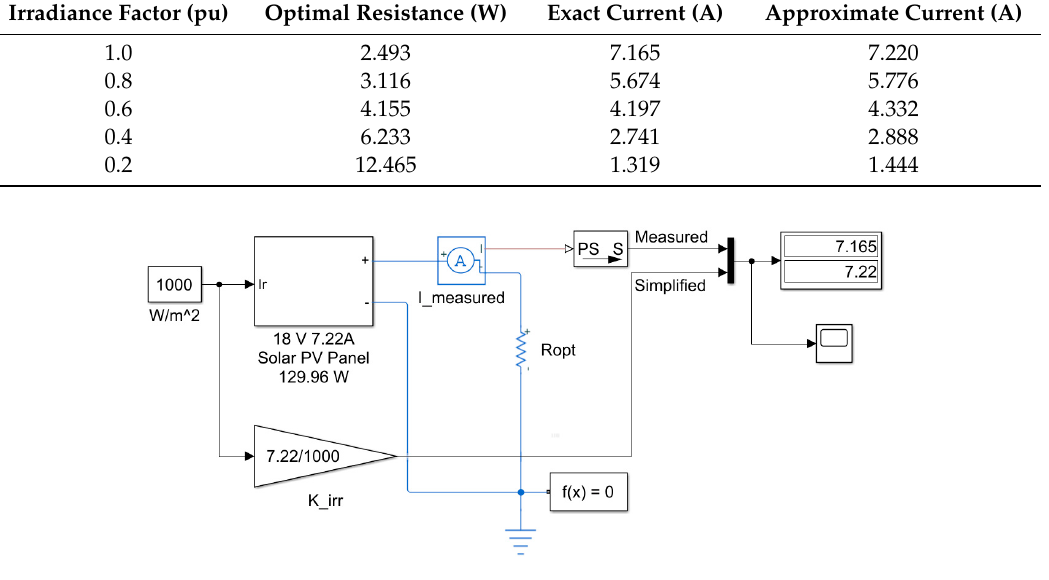
Figure 3. SIMULINK model of the photovoltaic (PV) panel. Table 2. Verification of Equations (1) and (2).